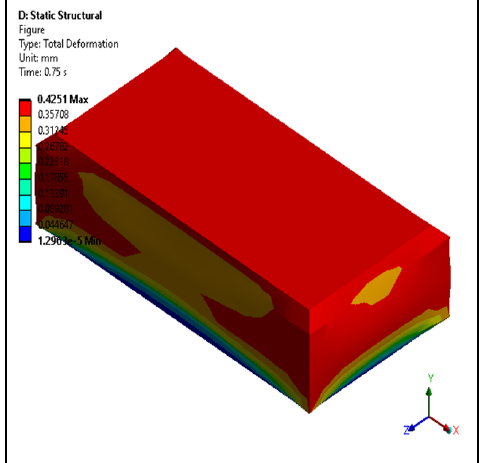
Figure 28. Total deformation of sustainable red mud bricks using ANSYS–HA.